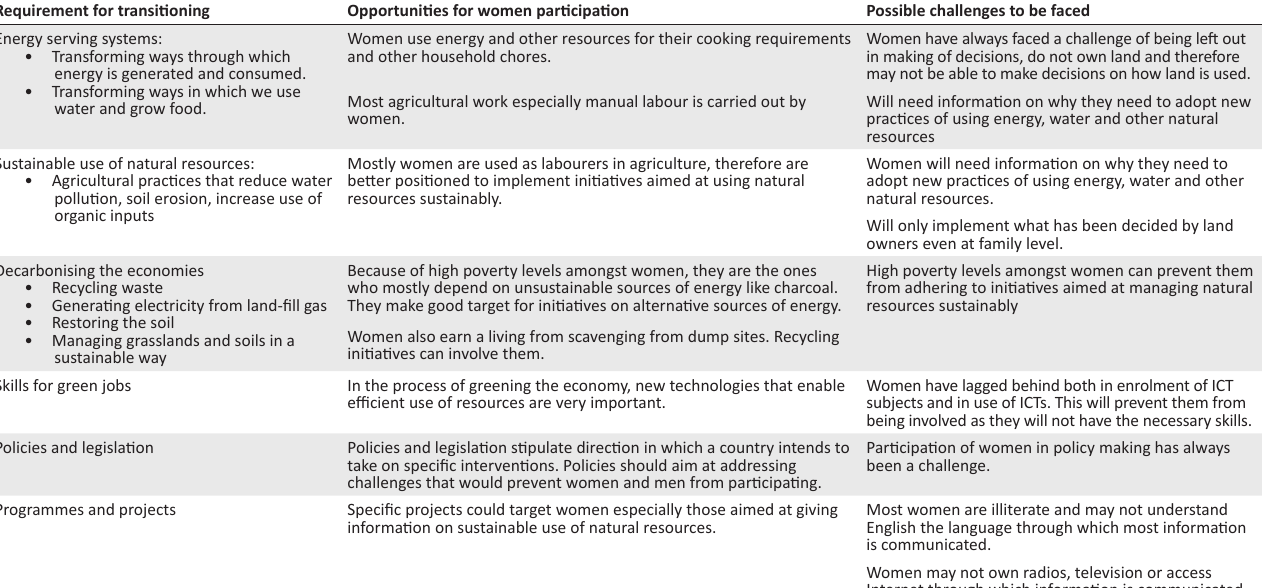
TABLE 4: Theoretical positioning of women’s participation in green economy initiatives and expected